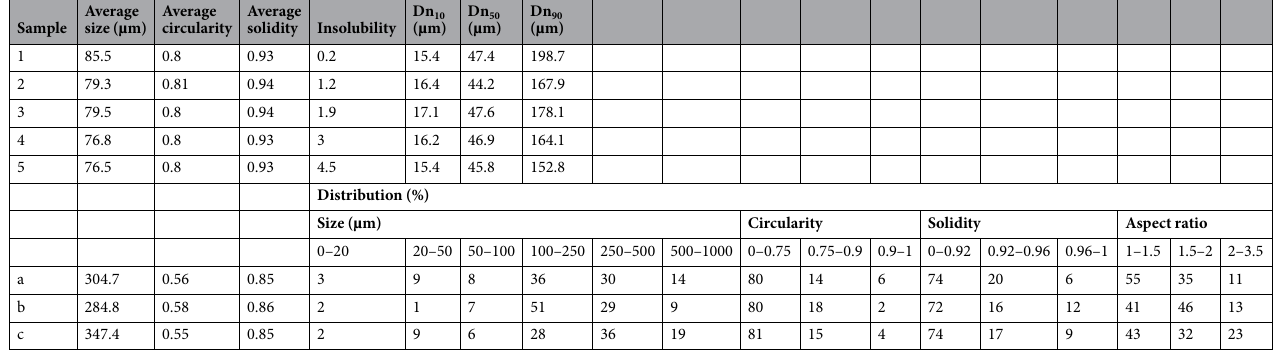
copper sulfate crystal where focus-stackings were performed for 25° step rotations, where edges and facets did not constitute matching markers or reference points from the different angles of view. Determining depth maps from the focus-stacks was also difficult, due to some remaining transparencies and reflections. Such reflections were minimized, however facets remained, appearing differently due to the varying particle’s thickness and shape